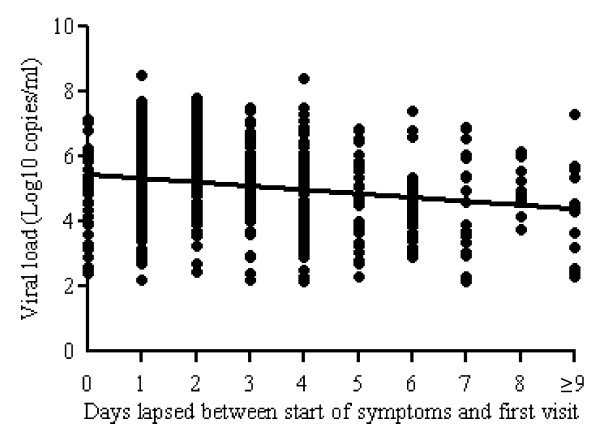
Correlation of initial viral load with the duration after symptom onset in 533 patients. The analysis was performed on 533 NPS collected during the first visit and sent to the Virology Laboratory of the National Institute for Infectious Diseases "L. Spallanzani", Rome, Italy for laboratory diagnosis (r = -0.203, p < 0.0001).